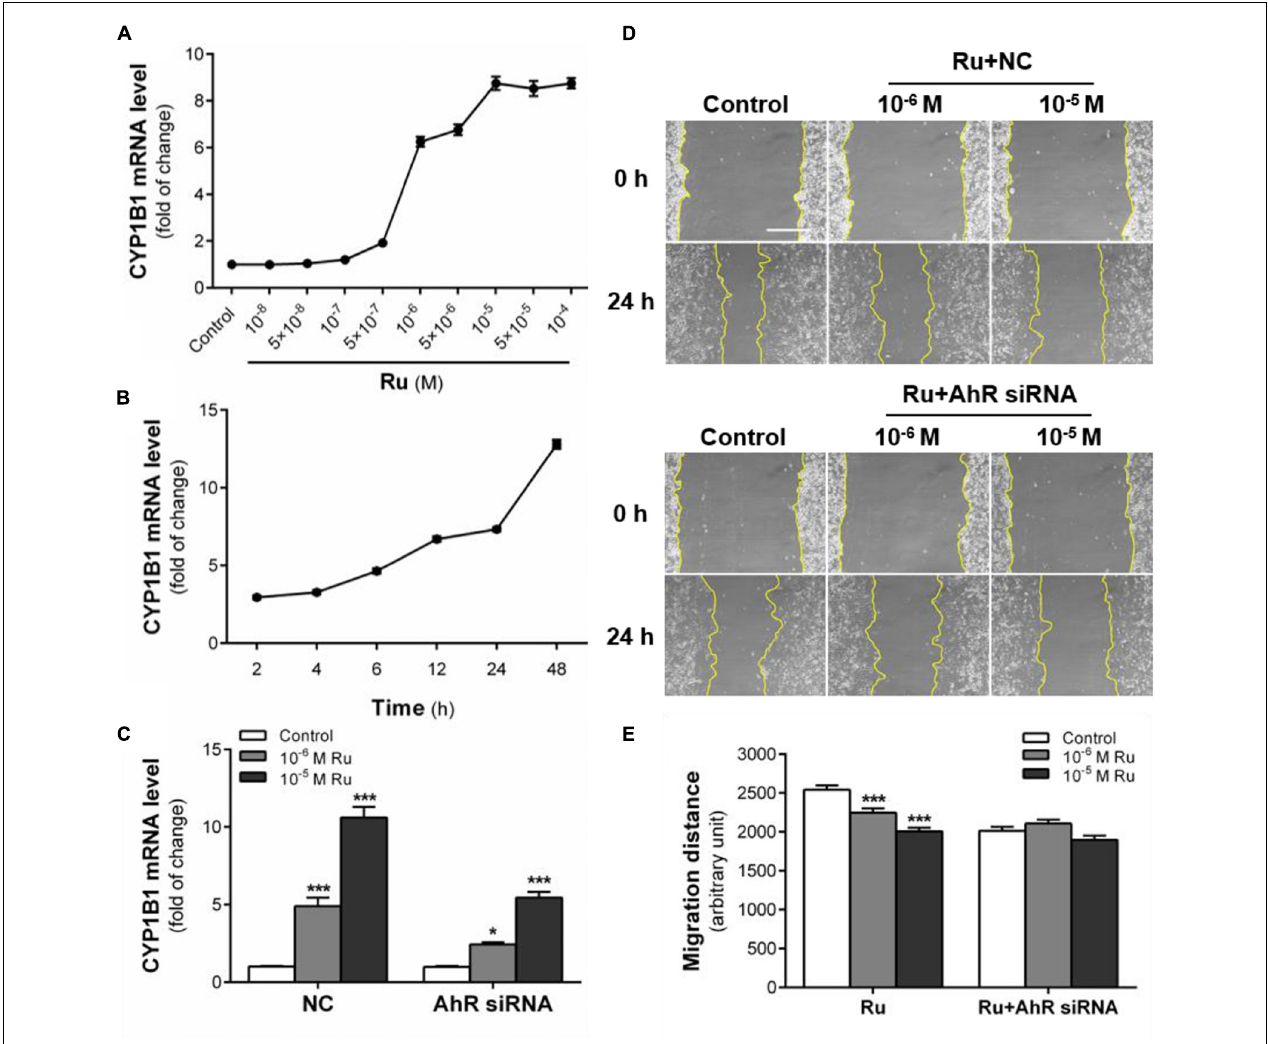
FIGURE 5 | AhR signaling pathway mediates the inhibition of rutaecarpine on U87 cells migration. (A) Dose relationship between rutaecarpine with AhR signaling pathway activation after 48 h treatment with 10 − 8 –10 − 4 M rutaecarpine or 0.1% DMSO. (B) Time relationship of rutaecarpine with AhR signaling pathway activation after 2, 4, 6, 12 24, 48 h treatment with 10 − 4 M rutaecarpine. (C) After 48 h treatment with rutaecarpine or 0.1% DMSO together with or without AhR siRNA pre-treatment, the mRNA expression of CYP1B1 in U87 cells. The mRNA expression of CYP1B1 in U87 cells was determined by qPCR analysis. GAPDH was used as an internal control for quantification. A wound healing assay was used to analyze the effect of AhR signaling pathway activation on U87 cells migration. AhR mRNA interference was treated as indicated. (D) Typical images of wound healing assay were taken at 0 and 24 h about different treatment groups. Scale bar = 0.5 mm. (E) Quantitative data graph of wound healing assay. After 24 h treatment with 10 − 6 and 10 − 5 M rutaecarpine or 0.1% DMSO, the distance of migration was counted. * p < 0.05, *** p < 0.001 compared with control group. All values are fold of control that was treated with the solvent and represent the mean ± SEM ( n = 3). SEM, standard error of the mean; Ru, rutaecarpine; NC, non-targeted